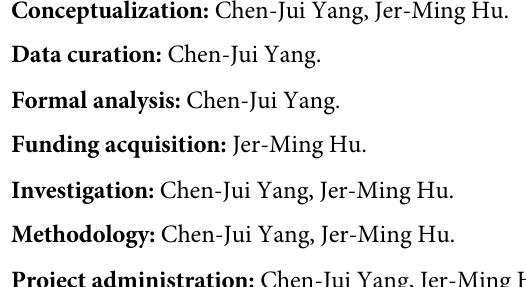
S5 Fig. Cophylogeny reconstruction of the history of host-parasite interaction between leaf-nodulated Ardisia and their symbiotic Burkholderia . One of the most common isomor- phic solutions using the event-based method in Jane. The Ardisia phylogeny is shown in black and the symbionts’ phylogeny is shown in blue. Cospeciation event is marked by an open and colored circle, duplication event is marked by a solid and colored circle, and duplication-with- host-switch event is marked by a duplication event with an arrow following the trajectory of the switching species. A yellow node indicates that there is another location of equal cost, and a red node means that all other locations to which it may be mapped are of higher cost. S1 Table. Voucher details and GenBank accession numbers of Ardisia , allies, and out- groups. S2 Table. Primers used for PCR and sequencing in this study. S3 Table. Detailed information of the Burkholderia s . l . sequences used in this study. S4 Table. Statistic values of comparing congruence within subtrees in TreeMap